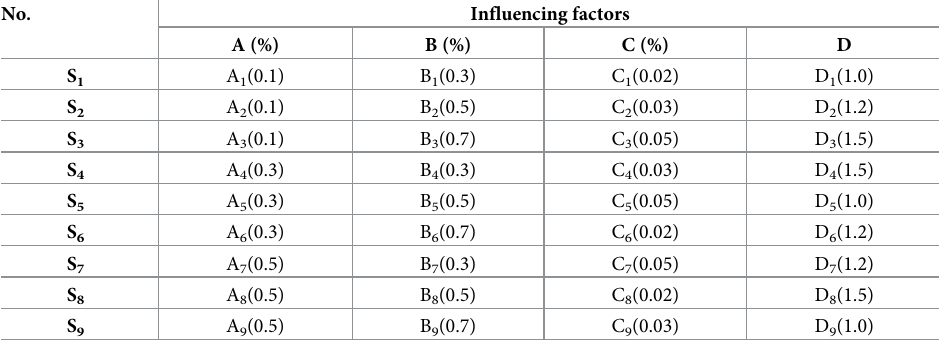
Fig 5. Compressive s compressive strength curves of the sealing material at different curing ages. https://doi.org/10.1371/journal.pone.0284140.g005 setting time, flow rate, expansion rate, and compressive strength. Table 3 presents the results of the orthogonal analysis of the proposed material. Based upon the influence of optimal sealing material ratio on the performance of the pro- posed sealing material, the optimum proportions were determined to be 0.3% compound quick-setting agent, 0.5% compound retarder, 0.03% expansive agent and a water-cement ratio of 1.2:1.0. After determining the optimal component ratio, the initial and final setting times of the sealing material were determined to be 9 min and 23 min, respectively, resulting in a density of 1.25 g/cm 3 , an expansion rate of 6.8%, fluidity of 336 mm and a 28-d compres- sive strength of 11.06 MPa. Table 2. Orthogonal (3 4 ) experimental